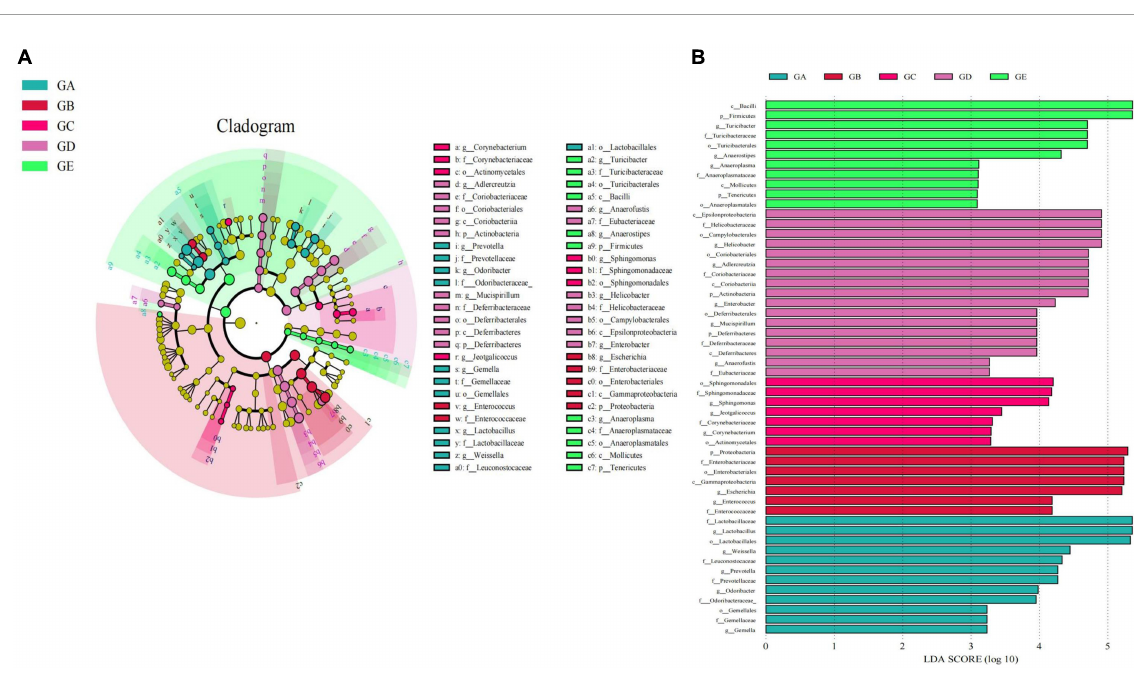
FIGURE8 LEFSe analysis of significant difference species at genus level in mice gut microbiota. (A) Cladogram diagram, (B) LDA